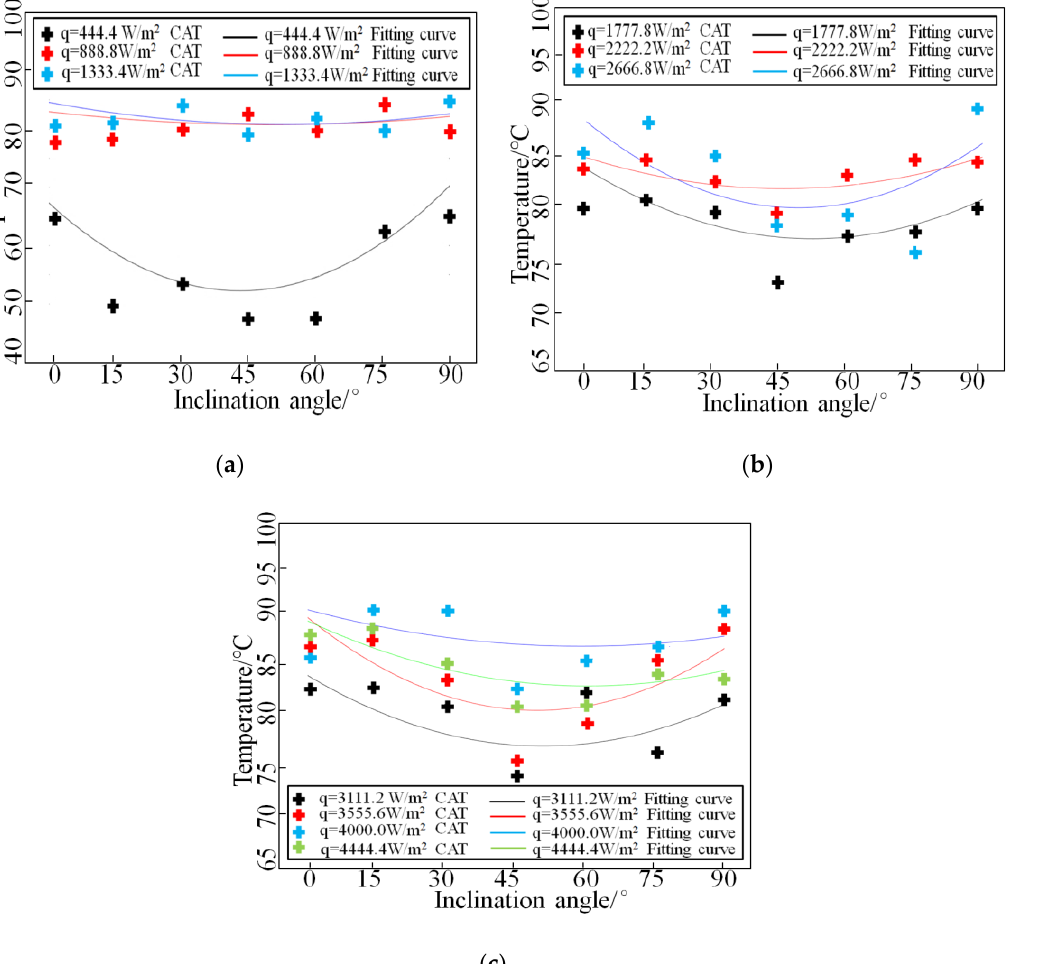
Figure 8. Fitted curve of the average value of stable operation temperature of heat flow density of 444~4444 W·m −2 . ( a ) q = 444~1333 W·m −2 , ( b ) q = 1778~2667 W·m −2 , ( c ) q = 3112~4444 W·m −2.